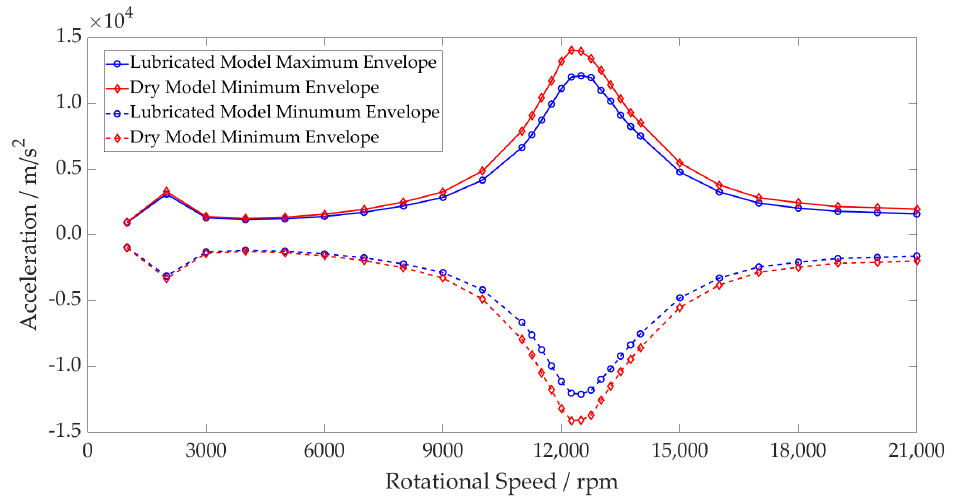
Figure 11. Inner Race Acceleration — Dry vs. Lubricated Operating Envelope.